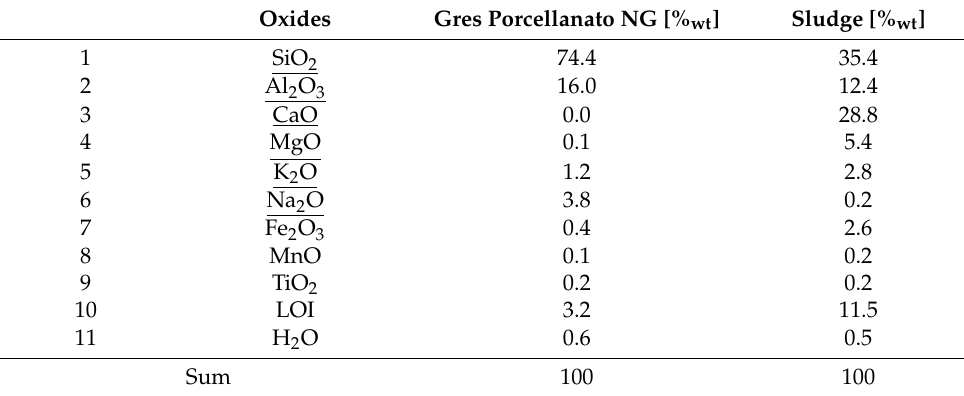
Table 1. Chemical analysis of raw materials.